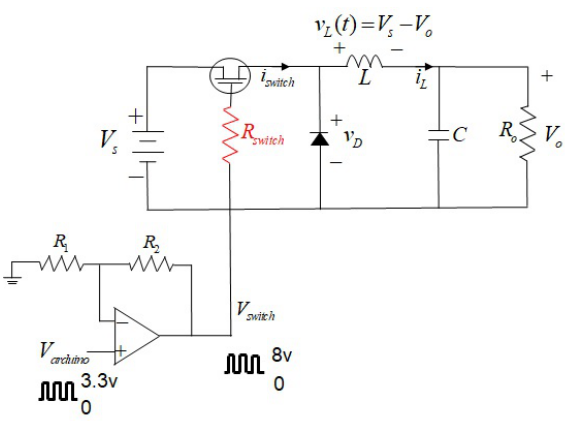
Figure 2. Schematic of simple buck converter for switching the current harmonics